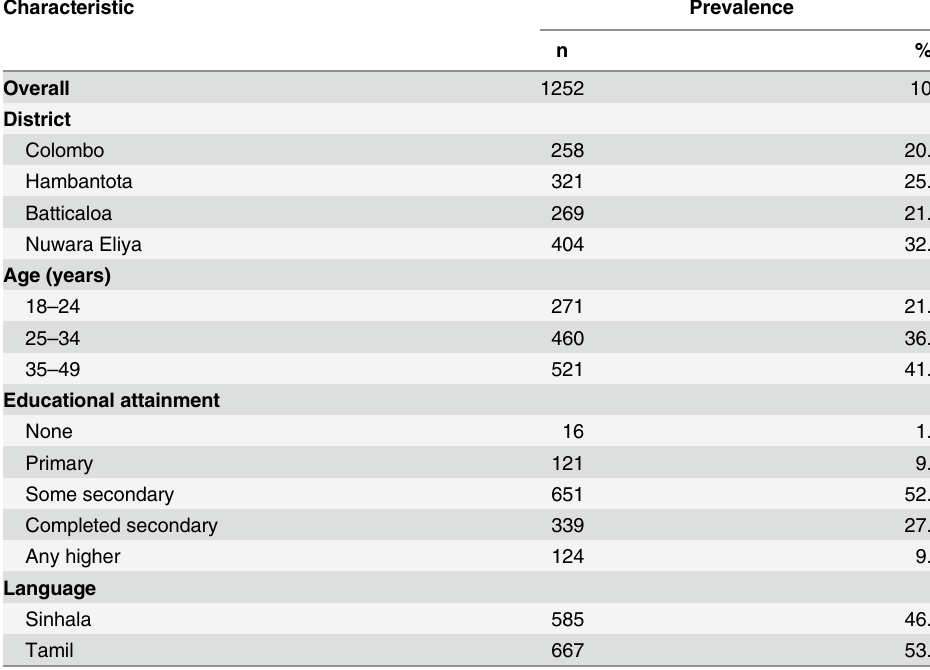
Table 1. Demographic characteristics of sample of ever-partnered Sri Lankan men (n = 1252), UN Multi-Country Study on Men and Violence in Asia and the Pacific, Sri Lanka, 2011 – 2012